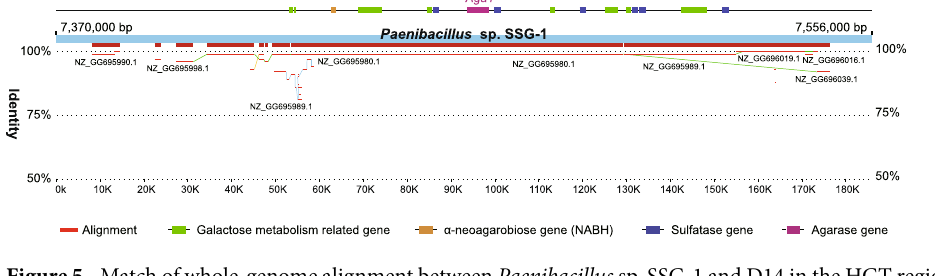
Figure 5. Match of whole-genome alignment between Paenibacillus sp. SSG-1 and D14 in the HGT region.